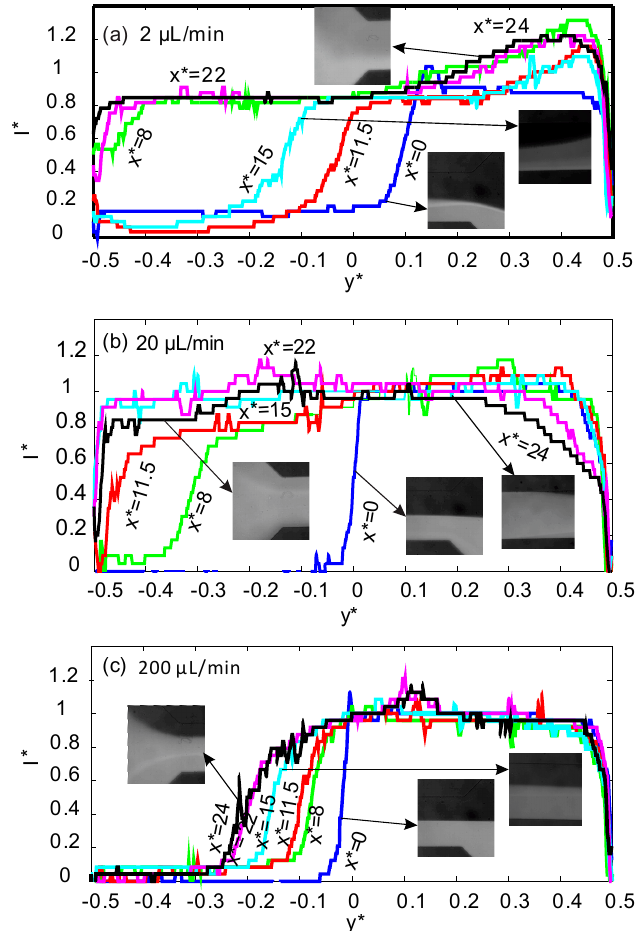
Figure 3. Normalized intensity across the normalized channel width y * for six positions of x * along the mixing channel with a ferrofluid concentration of 20% vol. ( x * = 0: blue, x * = 8: green, x * = 11.5: red, x * = 15: cyan, x * = 22: purple, x * = 24: black) and three different flow rates: ( a ) 2 µL/min; ( b ) 20 µL/min; ( c ) 200 µL/min.